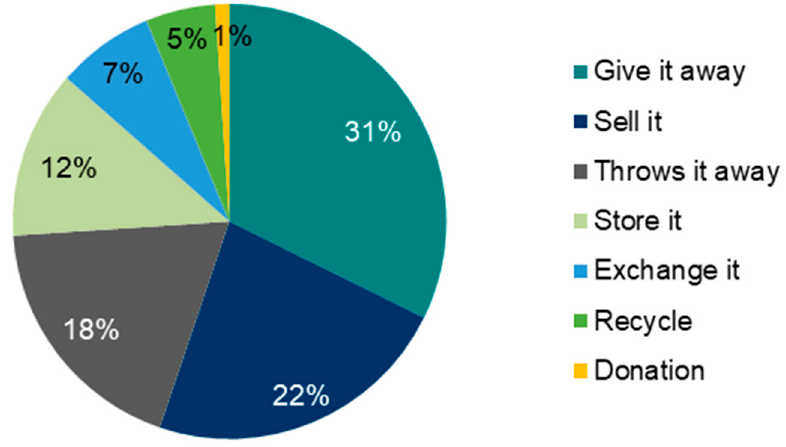
Figure 4. Ways people dispose of their electronic equipment. Source: Own elaboration based on the results obtained from the national survey (2018).